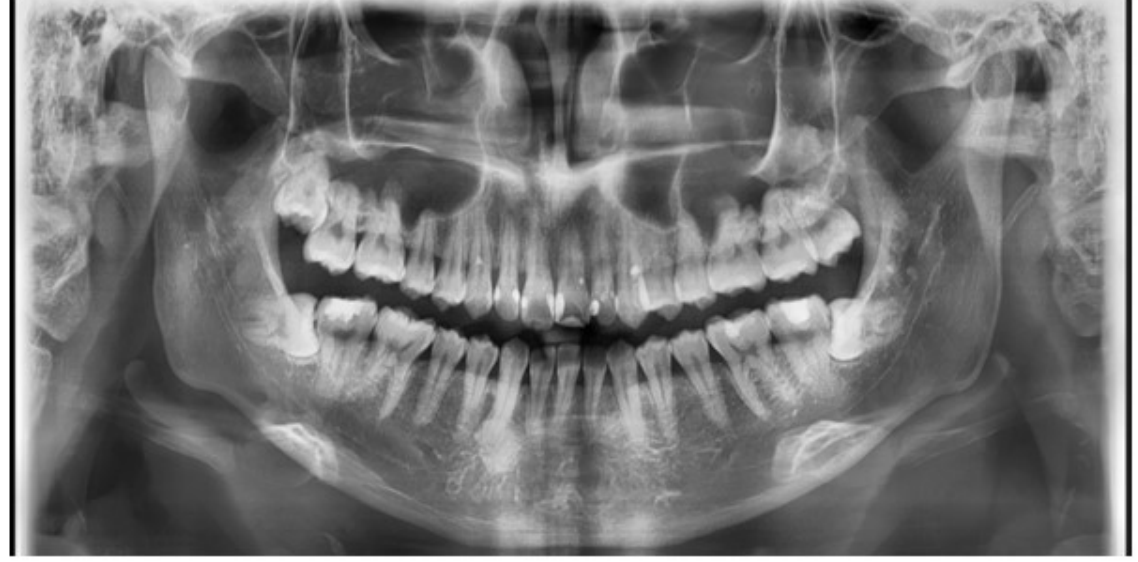
Fig. 5b - Panoramic radiograph - no radiological signs of radix entomolaris and C - shaped configura�on of root canals in the mandibular